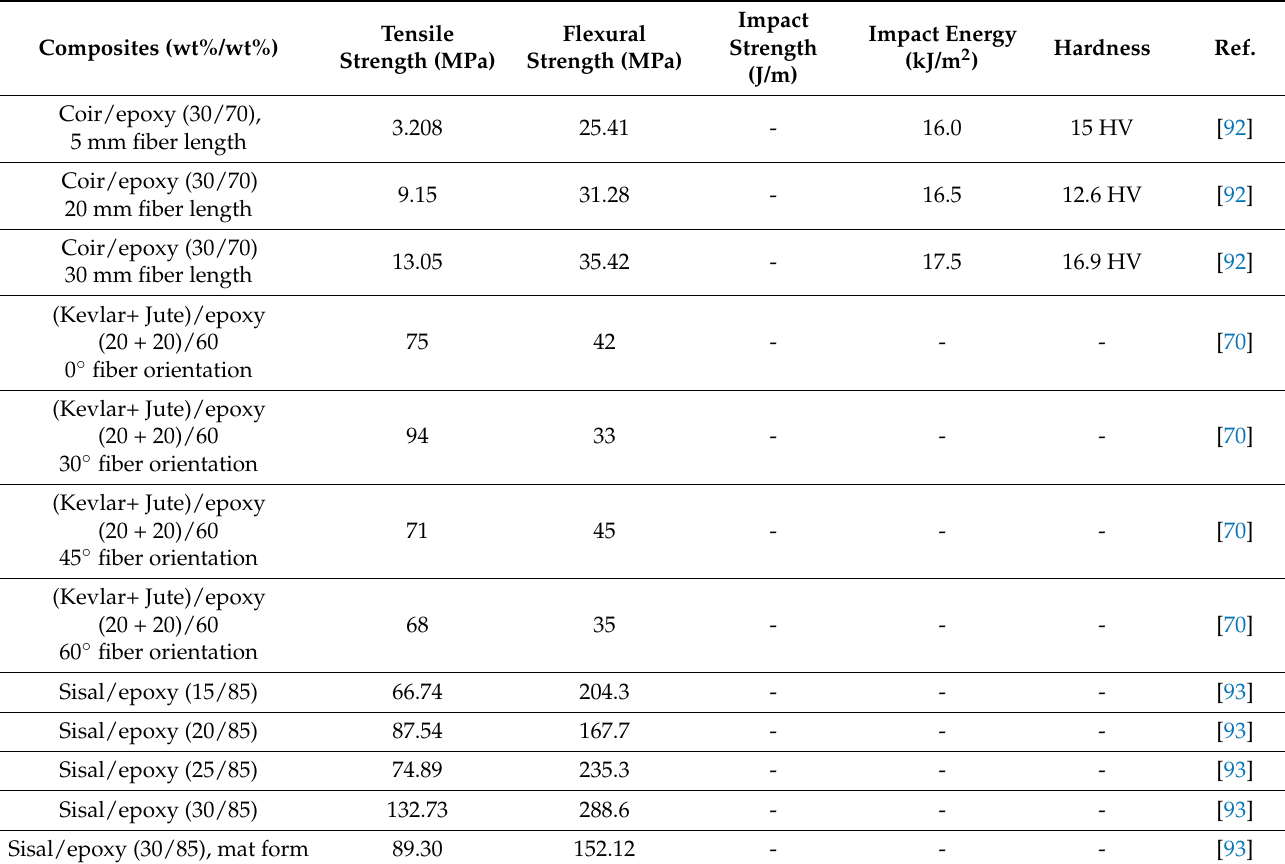
Table 4. Natural fiber–epoxy composites—mechanical behaviours